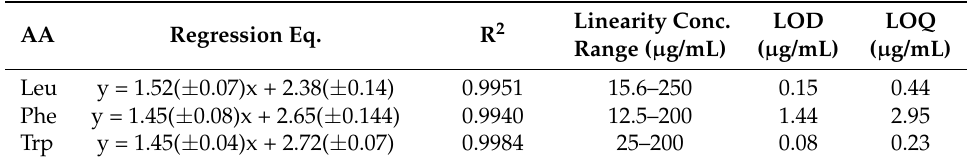
Table 1. The calibration data for the selected amino acids (AAs): regression equations, correlation coefficient (R 2 ) values, explored linearity ranges, and LOD and LOQ values.